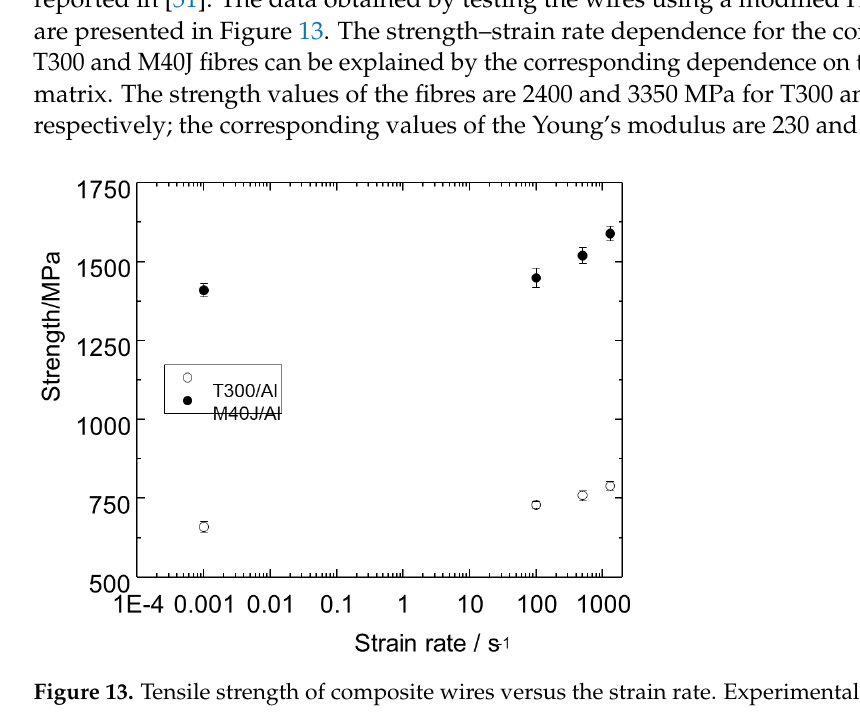
Figure 13. Tensile strength of composite wires versus the strain rate. Experimental data published in [51].